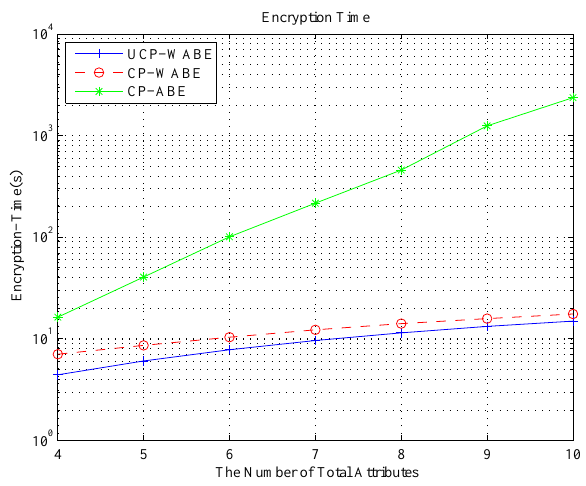
Figure 7. Encryption time cost for the changed number of access tree attributes.